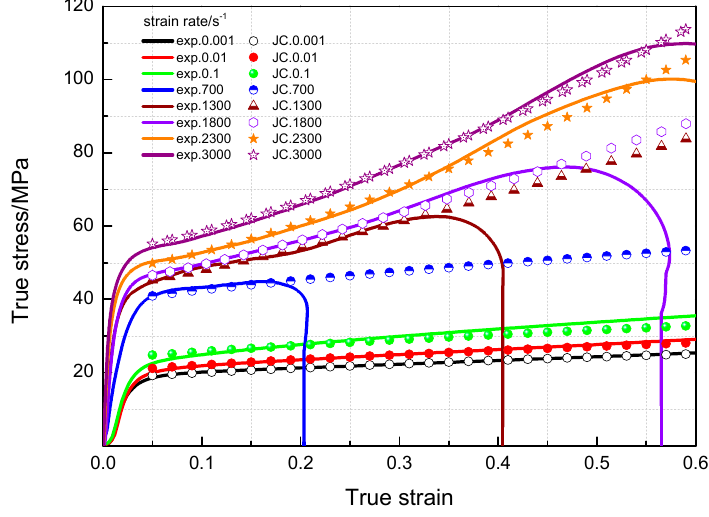
Figure 11. Comparison of JC model to experimental data at different strain rates.